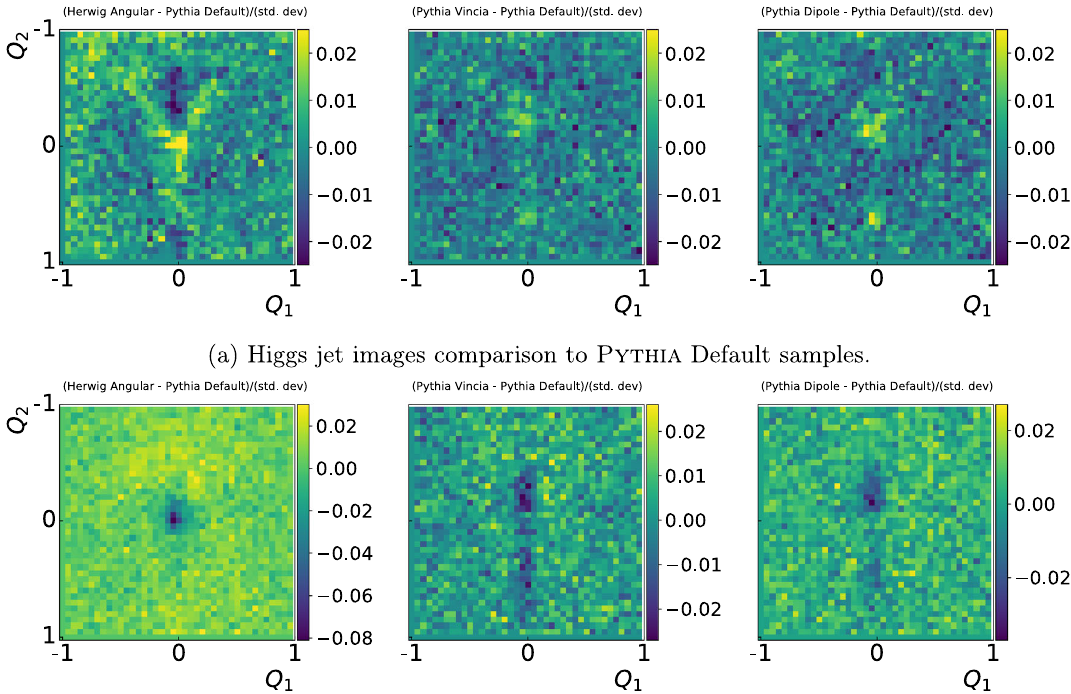
intensity in each pixel is the sum of the charged particle p T . The total intensity in each image is normalized to unity. Images in right column are the average difference between Higgs jet and QCD jet images